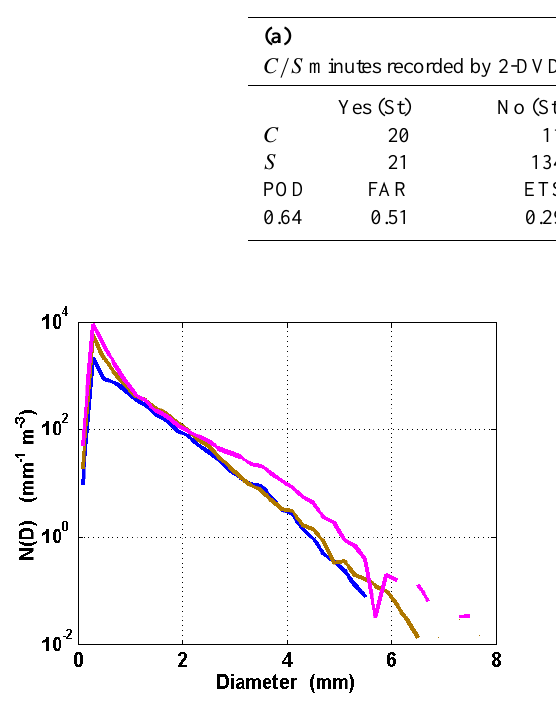
Figure 11. RSD averaged over the convective minutes for 13 September 2012 (blue), 12 October 2012 (brown), and 15 October 2012 (magenta).